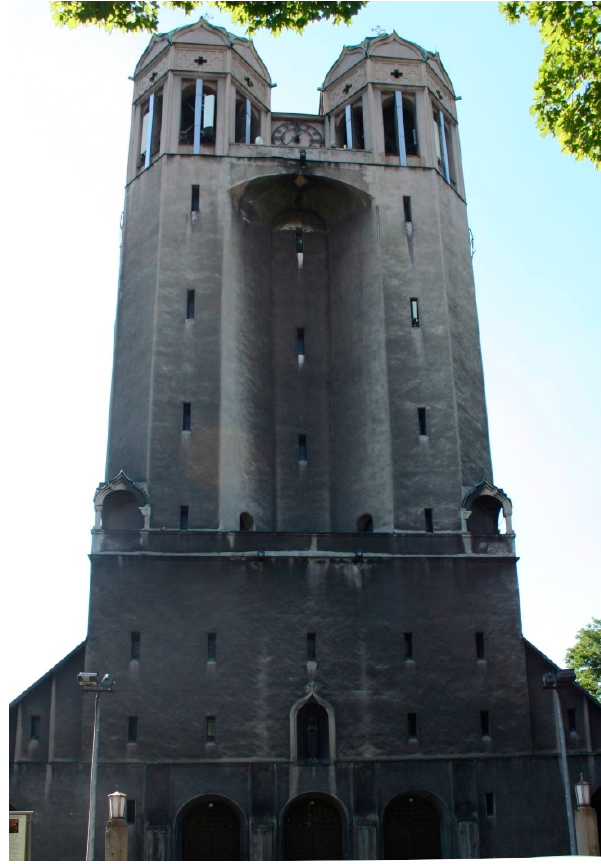
Figure 8. Bytom (Ger. Beuthen), Saint Barbara’s Church designed by Arthur Kickton, 1928–1931. Created by author.